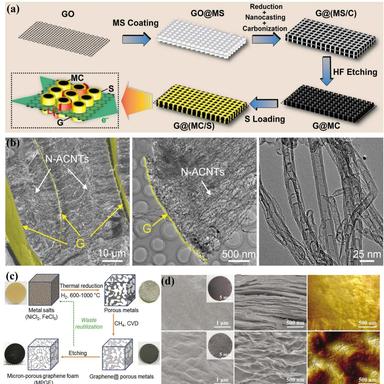
(a) Schematic illustration showing the preparation of the cathode Copyright 2018,American Chemical Society and (b) Structure characterization of N-ACNT/G hybrids: SEM and TEM images of N-ACNT/G hybrids; typical TEM image of the bamboostructured NCNT in the hybrids Copyright 2018, Wiley-VCH; (c) Schematic illustration of the synthesis of micron-porous graphene foam from metallic salt precursor Copyright 2019, Elsevier; (d) Top-down: cross-sectional SEM images, and AF